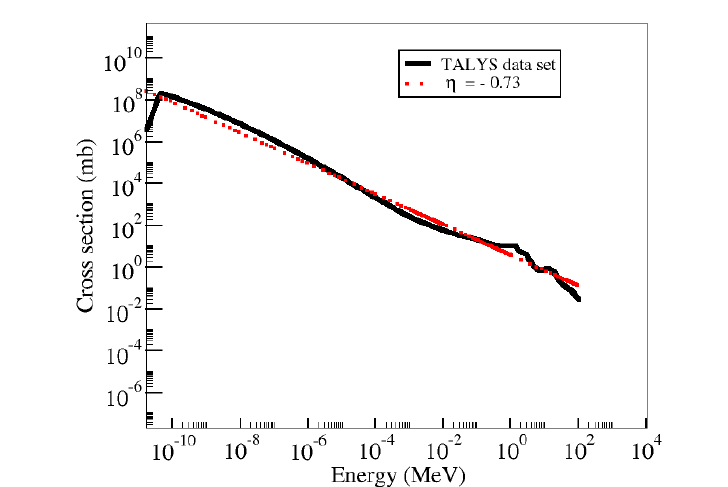
Figure 3. Neutron capture cross section off 58 Ni. The solid black line shows the full dataset obtained with TALYS 1.9 [10]. The dotted red line shows our fit to a power law as in Equation (3).